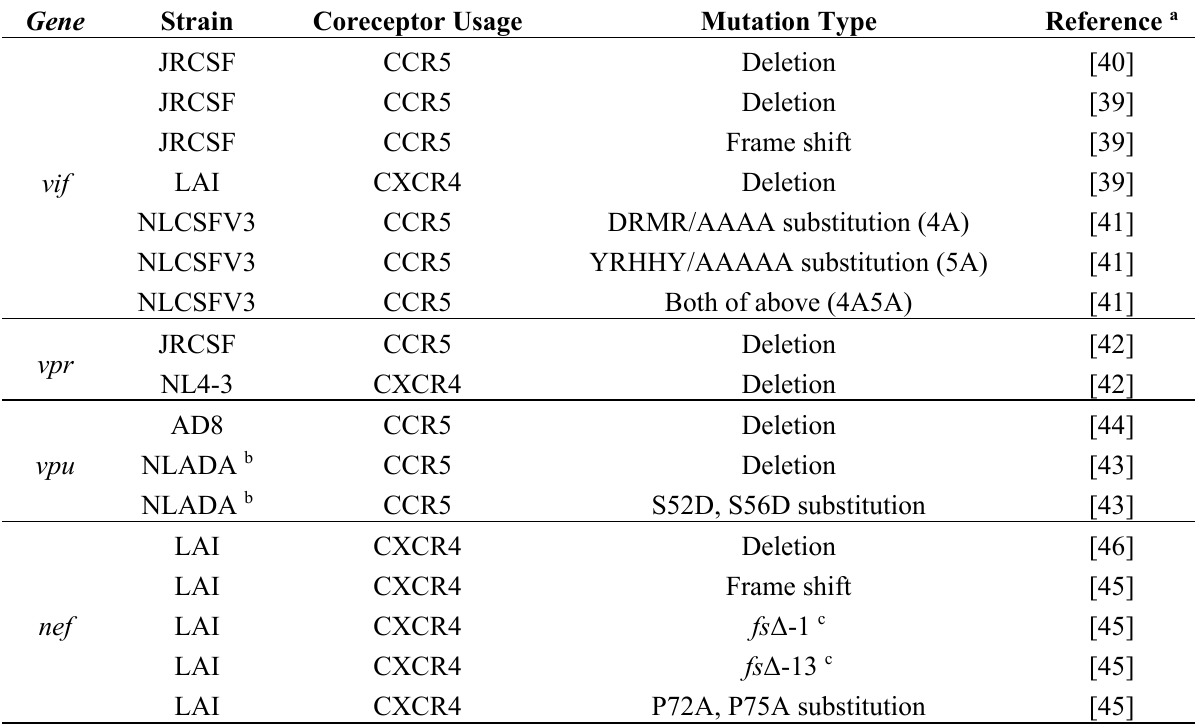
Table 1. HIV-1 mutants used in the studies of humanized mouse